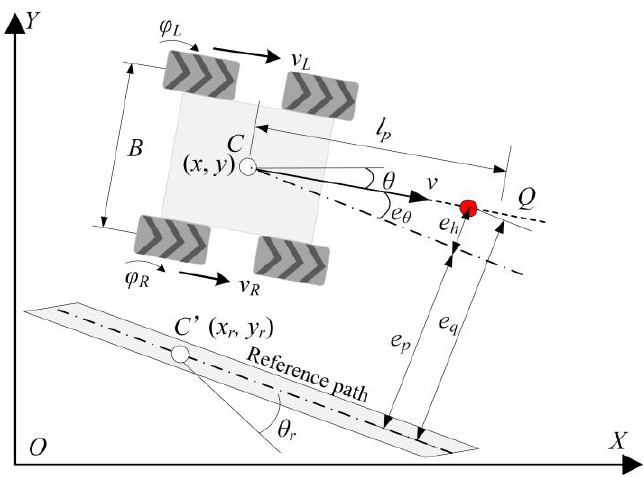
Figure 1. Description of the kinematic model with error definition for path tracking. A generalized coordinate vector q = [ x , y , θ , ϕ L , ϕ R ] T of the wheeled robot is